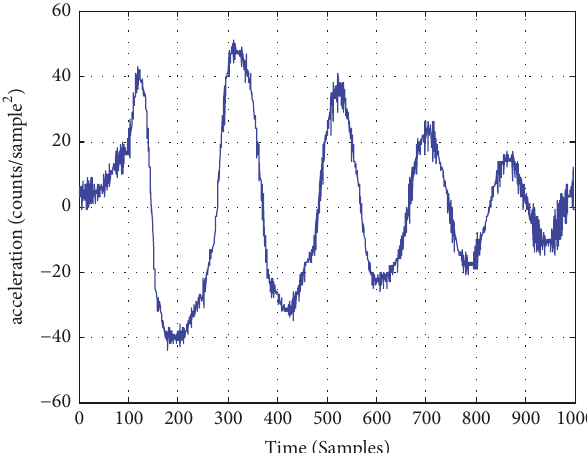
Figure8:Thewaveformoftheaccelerationcausedbythephasebias.